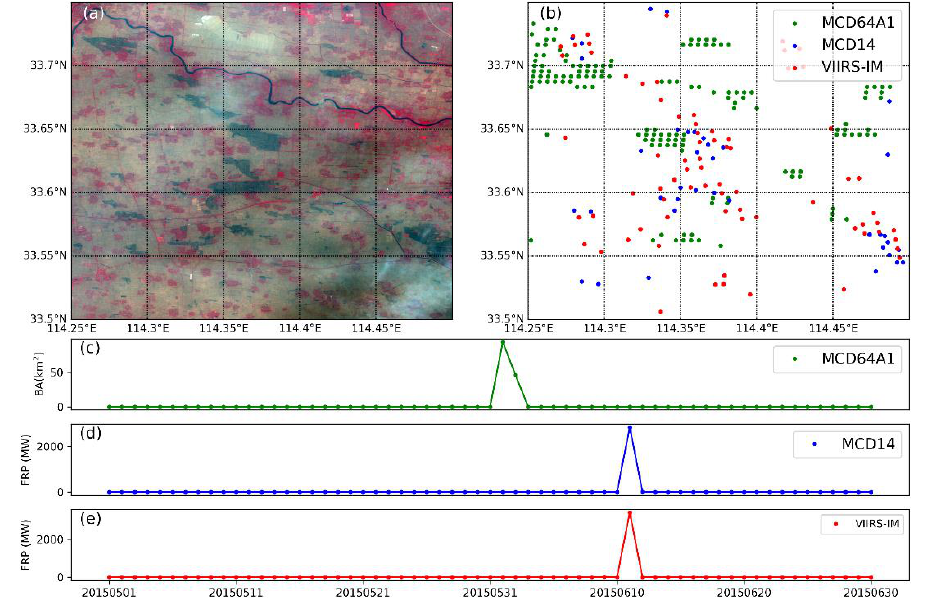
Figure 9. Fire activity within a 0.25° GFED grid cell centered at 33.625° N, 114.375° E in eastern China, May–June 2015? ( a ) Landsat-8 NIR false colour composite of 19 June 2015, after fire activity occurred in this grid cell. Recently burned areas appear dark in this rendition. ( b ) Spatial, and ( c – e ) temporal distribution of three fire products, MCD64A1 BA data, along with MCD14 and VIIRS-IM AF data. The spatial and temporal disagreement of MCD64A1 with MCD14, VIIRS-IM and the Landsat 8 imagery indicates that the burned area detected here by MCD64A1 seems likely to be caused by non-fire processes (e.g., crop harvesting) and is therefore represents an error of commission rather than true fire activity. When the fires do occur (as seen in the AF data) the MCD61A1 then fails to detect their ‘real’ burned area, resulting in a BA error of omission.